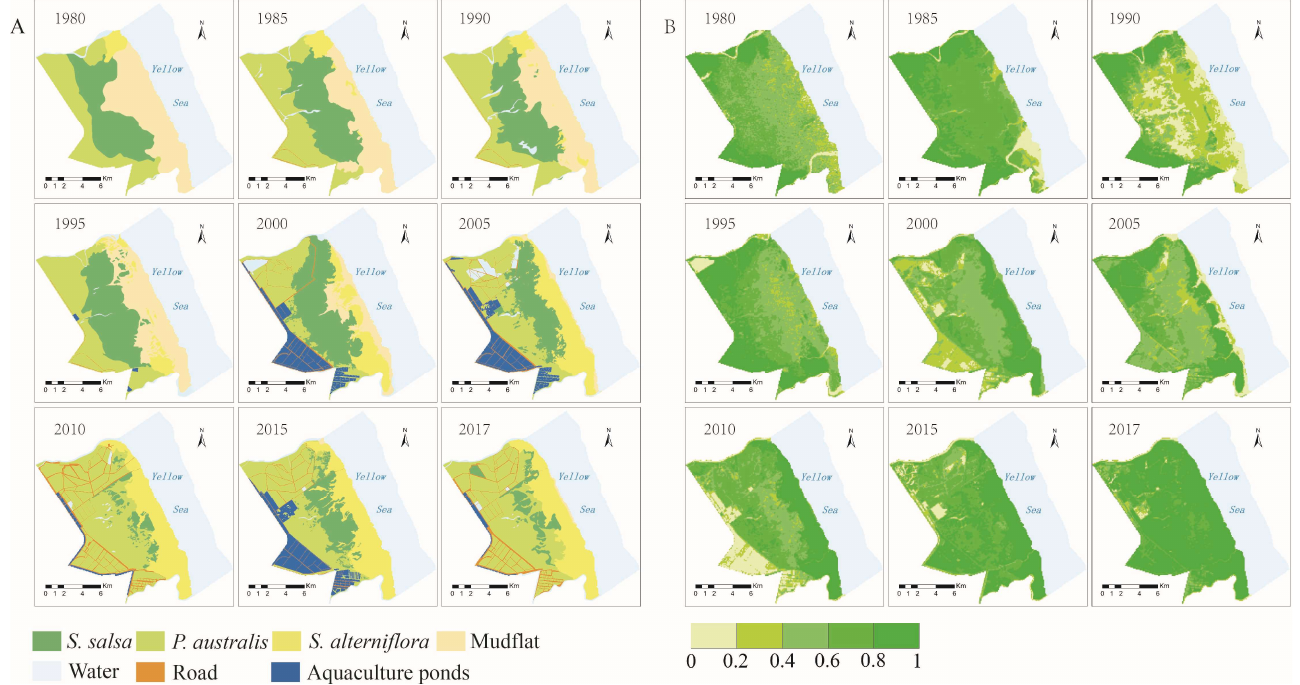
Figure 5. Vegetation coverage distribution map of coastal wetland in Yancheng. ( A ) is the distribution map of coastal wetland vegetation types. ( B ) is the distribution map of coastal wetland vegetation coverage.